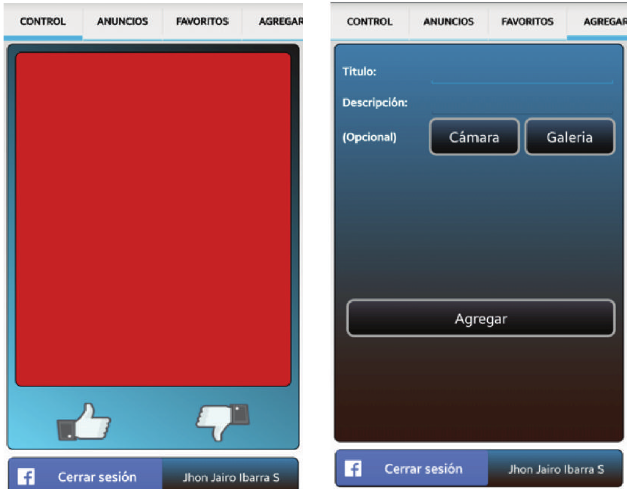
Figure 9: User pad control and ads post.